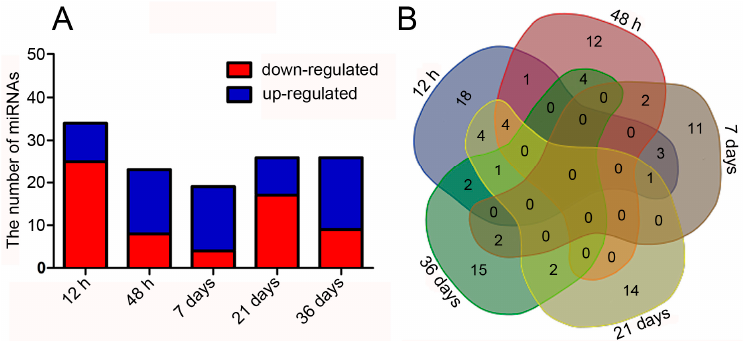
Figure 5. Changes in miRNA expression levels in H 2 -exposed PEMs. The histogram ( A ); and Venn diagram ( B ) show the number of differentially expressed miRNAs at different time points.